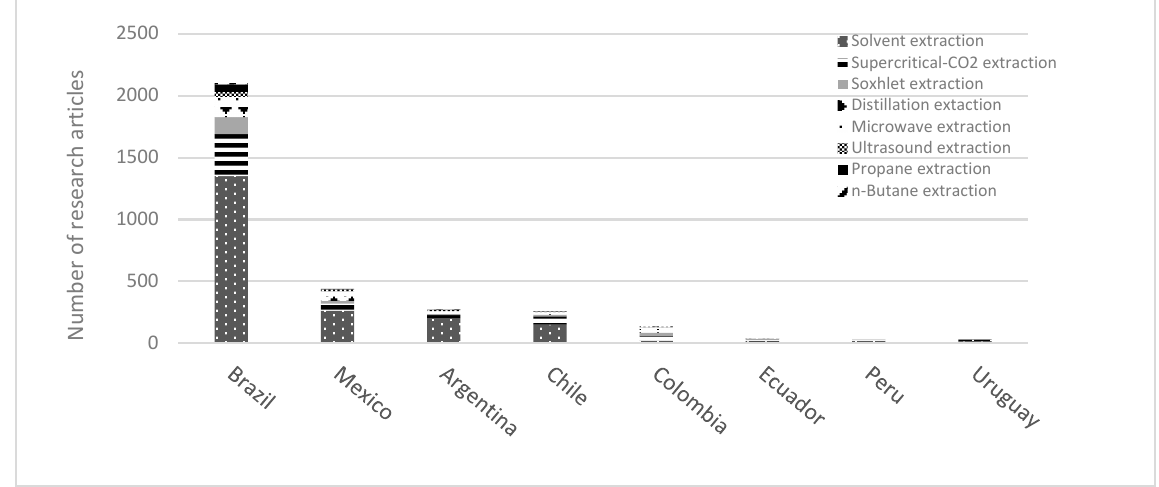
Figure 5. Extraction processing techniques in research articles contributed by Latin American coun- tries.